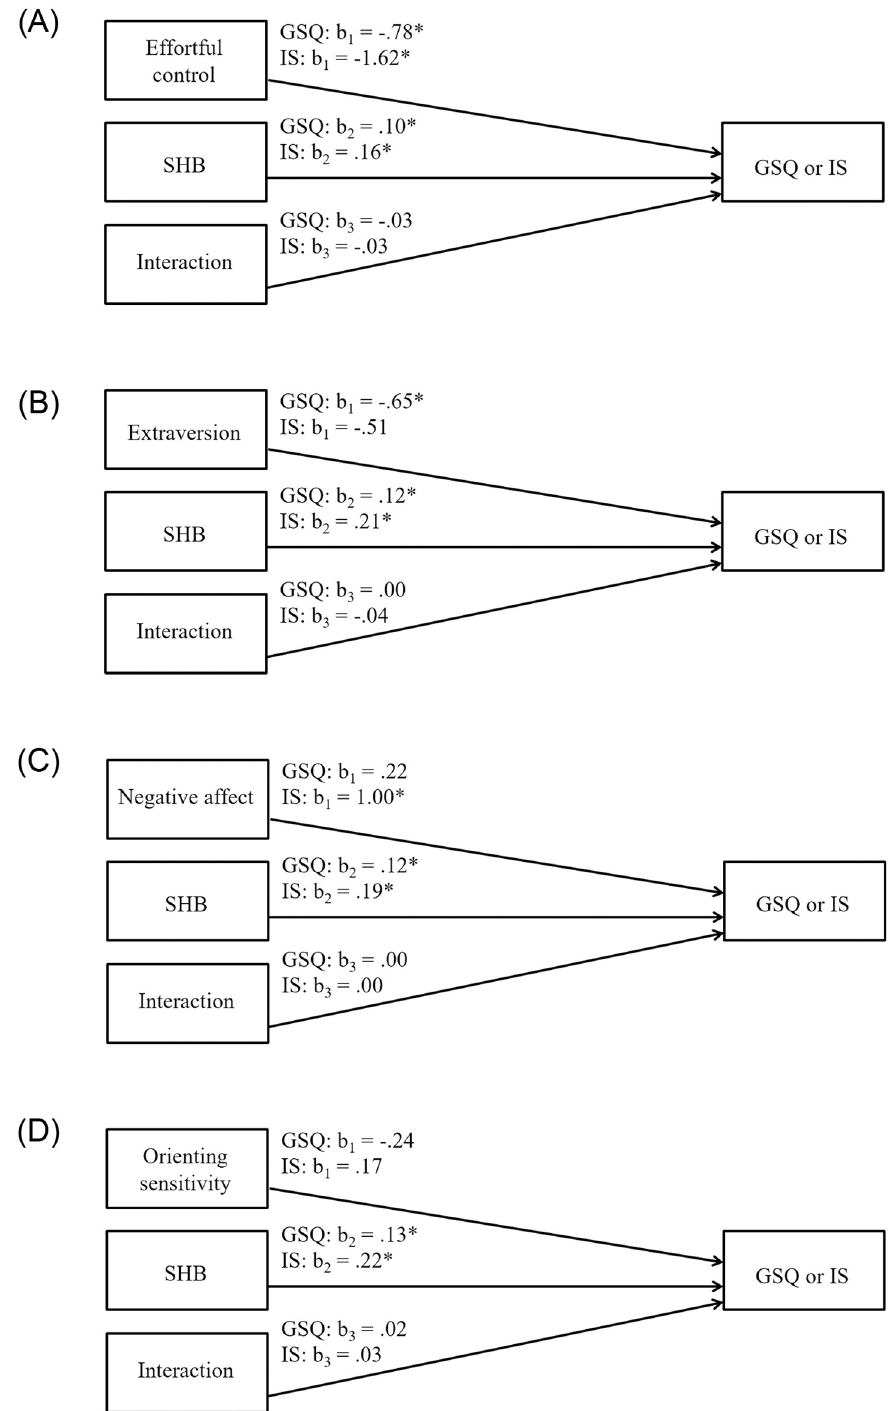
Fig 2. Panel A. Simple moderation analyses: Effortful control. Simple moderation analyses were conducted to identify whether the SHI composite moderated the effect of (1) effortful control on PSQI global scores and (2) effortful control on ISI scores. Covariates were included in the models as described in the Results section. Significant effects are indicated: � p < .05. Panel B. Simple moderation analyses: Extraversion. Simple moderation analyses were conducted to identify whether the SHI composite moderated the effect of (1) extraversion on PSQI global scores and (2) extraversion on ISI scores. Covariates were included in the models as described in the Results section.